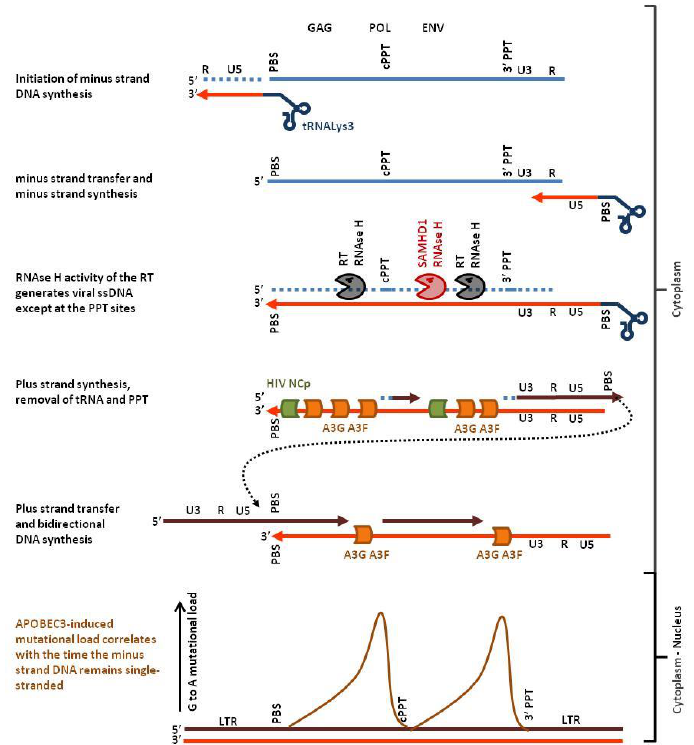
Figure 2. Hotspots of APOBEC3 editing in the HIV genome. Host cell tRNALys3 ( dark blue ) hybridizes to the primer binding sequence (PBS) of the single stranded plus-strand RNA genome ( light blue ) and initiates minus strand DNA synthesis ( light red ). After strand transfer, reverse transcription proceeds up to the PBS yielding minus-strand DNA.